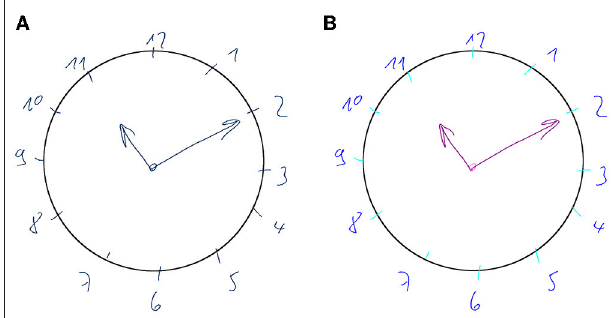
FIGURE 6 | Renderings of the original input (A) as recorded by the digital pen during the data collection with a subject performing the ROCF. The automated system segments the strokes into the 18 ROCF sub-figures, which are represented by different colors (B) . Based on this segmentation the algorithm scores the individual sub-figures, from 0 = “not present,” to 2 = “correct” (Duley et al., 1993).